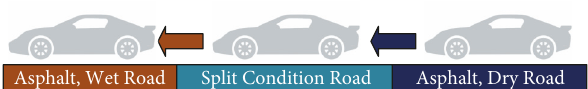
Figure 8: Scene of direct braking friction control under μ -split condition of different road